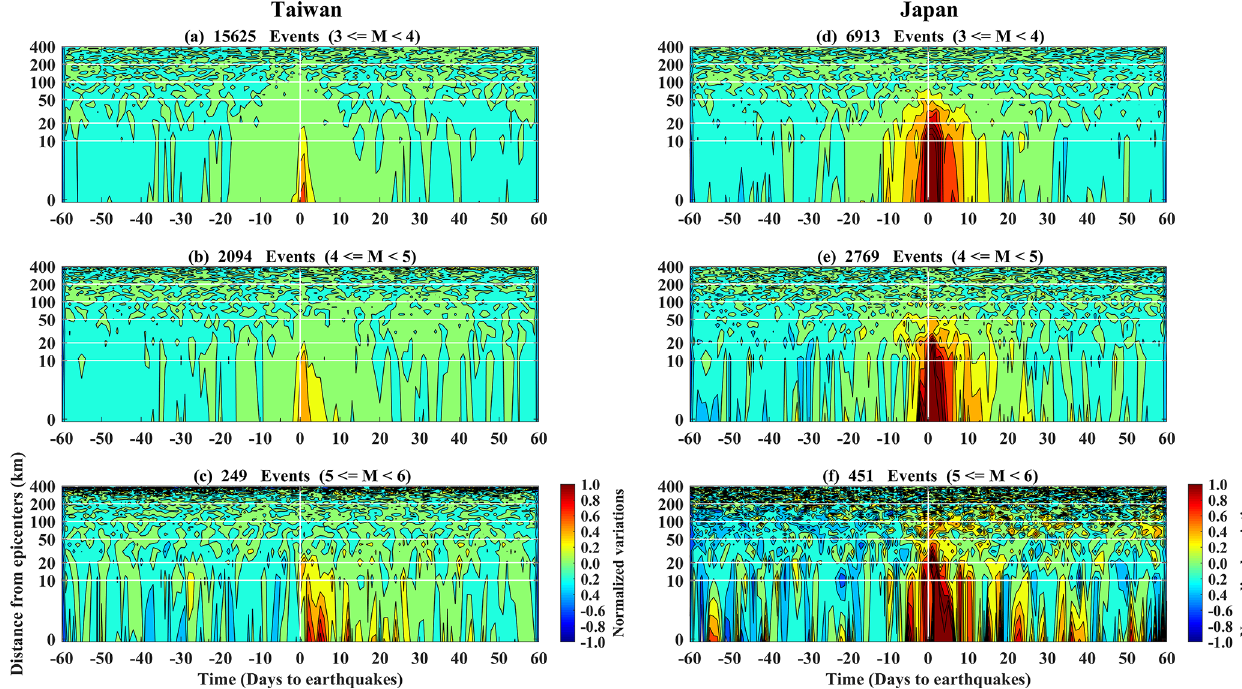
Figure 2. Changes of the normalized spatiotemporal variations in Taiwan and Japan. The normalized variations corresponding to the seismic density in Taiwan and Japan (in Fig. 1) are shown in the left and right panels, respectively. The colors reveal changes of the normalized variations at distances from the epicenters ranging from 0 to 400km up to 60d before and after quakes in a particular magnitude